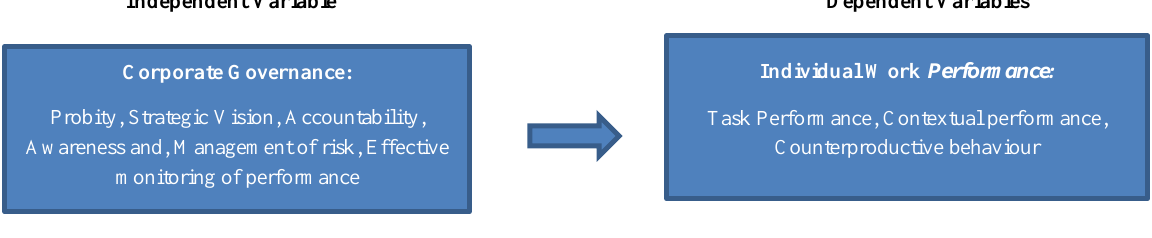
Figure 1 : The conceptual framework reflects the relationship between corporate governance; Source: ISA SED (Commission on Higher Education) and Koopmans et al, (2011) and Abun, et.al (2021). It explains that corporate governance affects individual work performance. Good corporate governance results in good individual work